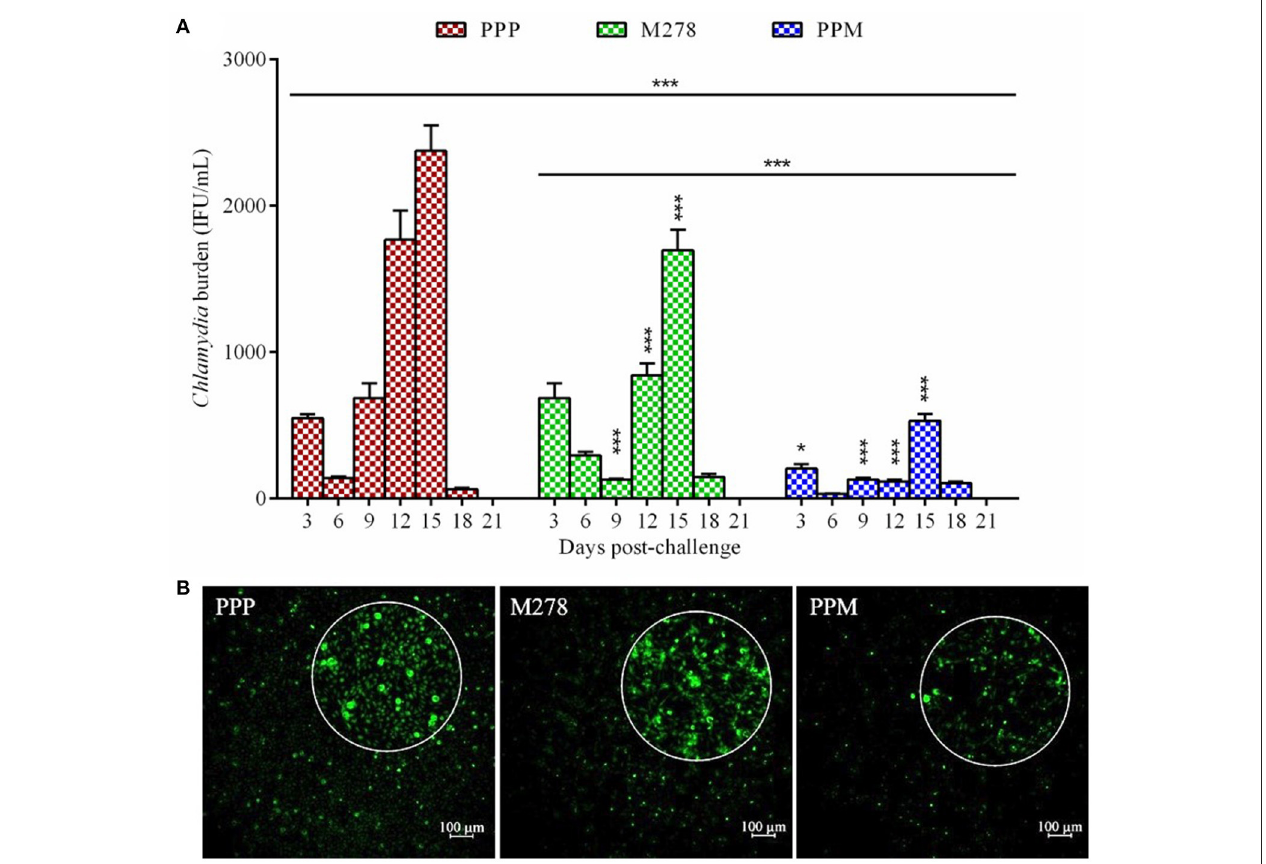
FIGURE 1 | Quantification of C. muridarum burden from vaginal cultures of mice following a genital tract challenge infection. Groups of mice received three subcutaneous immunizations at 2 weeks intervals with either bare M278, PPM, or the PPP control. Each mouse per group was challenged intravaginally with 1 × 10 5 IFU (inclusion forming units) of C. muridarum 3 weeks following the last immunization. Cervico-vaginal swabs were collected for a period of 3 weeks post-challenge for quantification of IFUs after propagation in McCoy mouse fibroblasts. Each bar represents the mean ± standard deviation of IFU counts (IFU/mL) for each group of mice at the indicated time-points (A) . Immunofluorescence microscopy visualization of C. muridarum IFU (green) in fibroblasts (with magnified view) exposed to cervico-vaginal swabs from immunized mice at the 12 day post-challenge time-point (B) . Statistical analysis in (A) was performed using ANOVA followed by Tukey’s Post-test. Significant differences in IFU counts between the M278 and PPM immunized groups and the PPP immunized control group were considered at *** P < 0.001 and * P < 0.05. PPP (PLA-PEG-PBS immunized group); M278 (bare M278 immunized group); PPM (PLA-PEG-M278 immunized